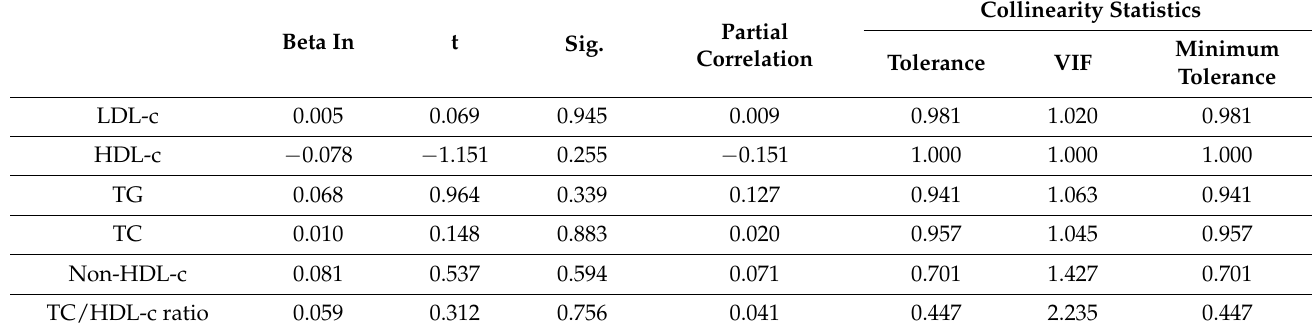
Table 11. Independent variables excluded as predictors of